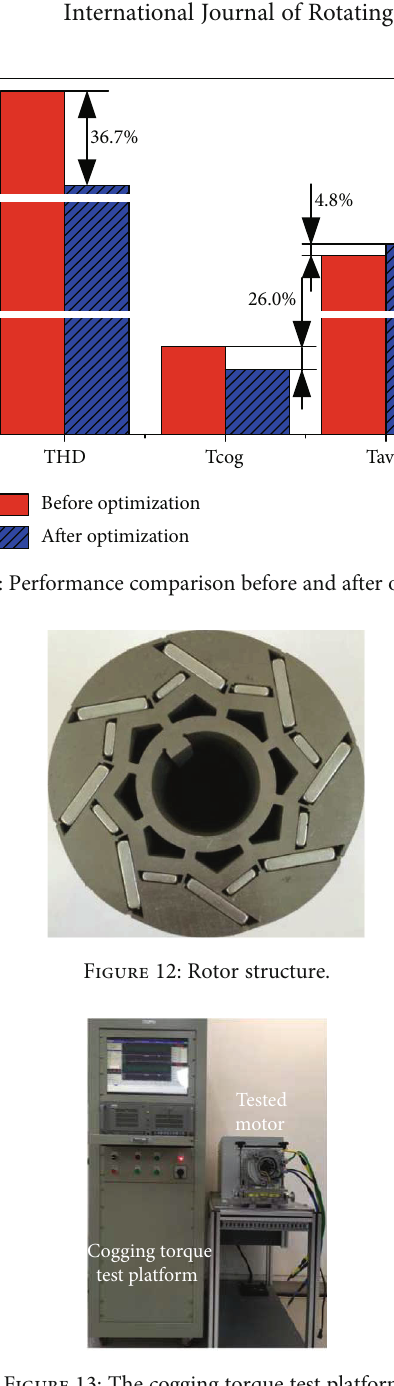
Figure 13: The cogging torque test